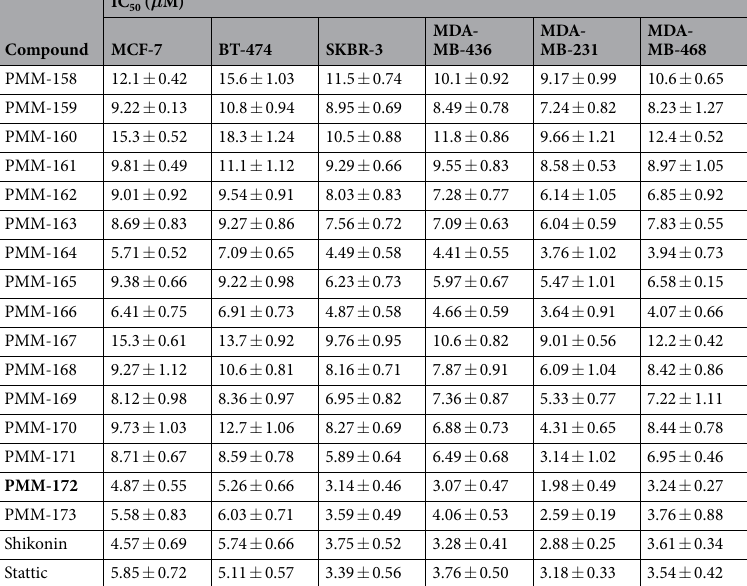
Table 2. Anti-proliferative activity against six kinds of breast cancer cells by all compounds.